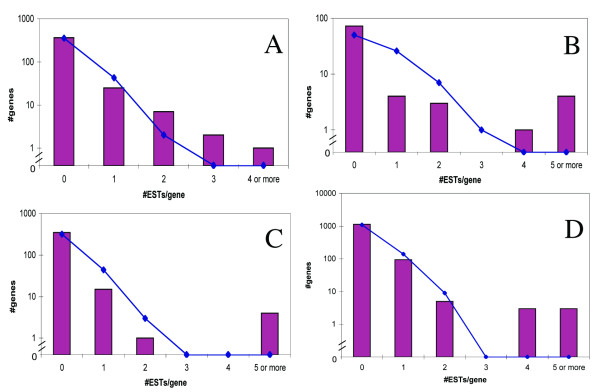
Distribution of EST coverage for OR genes. Bars show observed distributions for ESTs (spliced and non-spliced) coverage in non- olfactory tissues. The ESTs utilized for the distributions calculation were from normal tissues, non-subtracted and non-normalized libraries. Distributions for A. human intact ORs, B. human 7E subfamily ORs, C. human pseudogenes (excluding 7E subfamily members), D. mouse ORs (intact and pseudogenes). Solid lines are computed Poisson distributions based on the average value of ESTs per OR gene. The fit to the expected Poisson distributions was tested using the Kolmogorov-Smirnov test. The resulting p-values are: 0.998 for A, 0.003 for B, 0.401 for C and 0.591 for D.